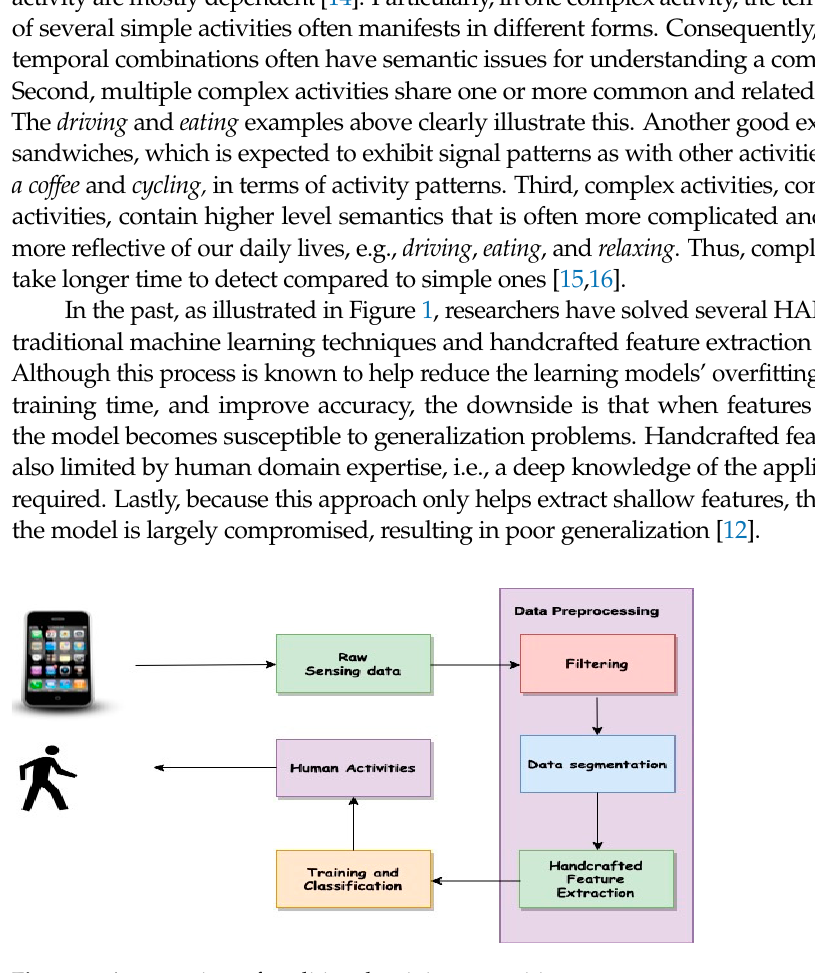
Figure 1. An overview of traditional activity recognition processes.